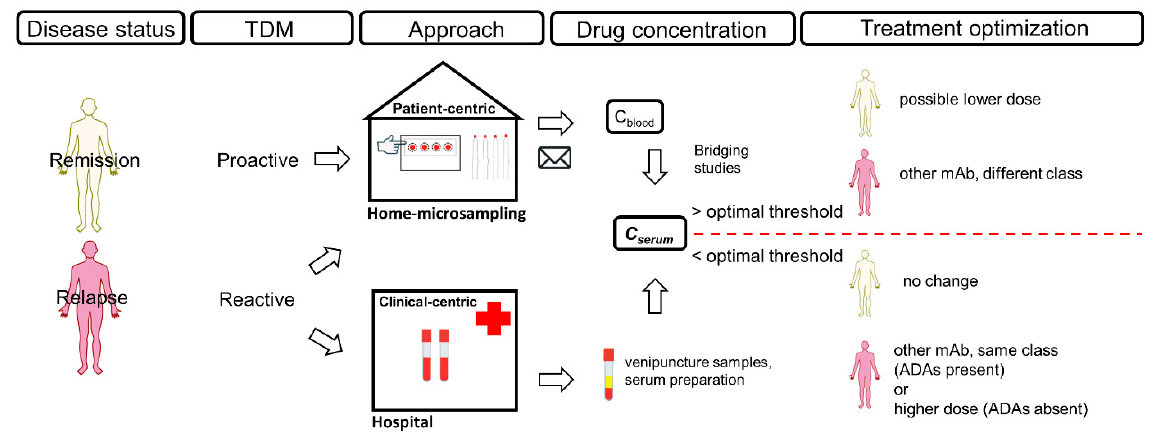
Figure 1. TDM process involving microsampling.